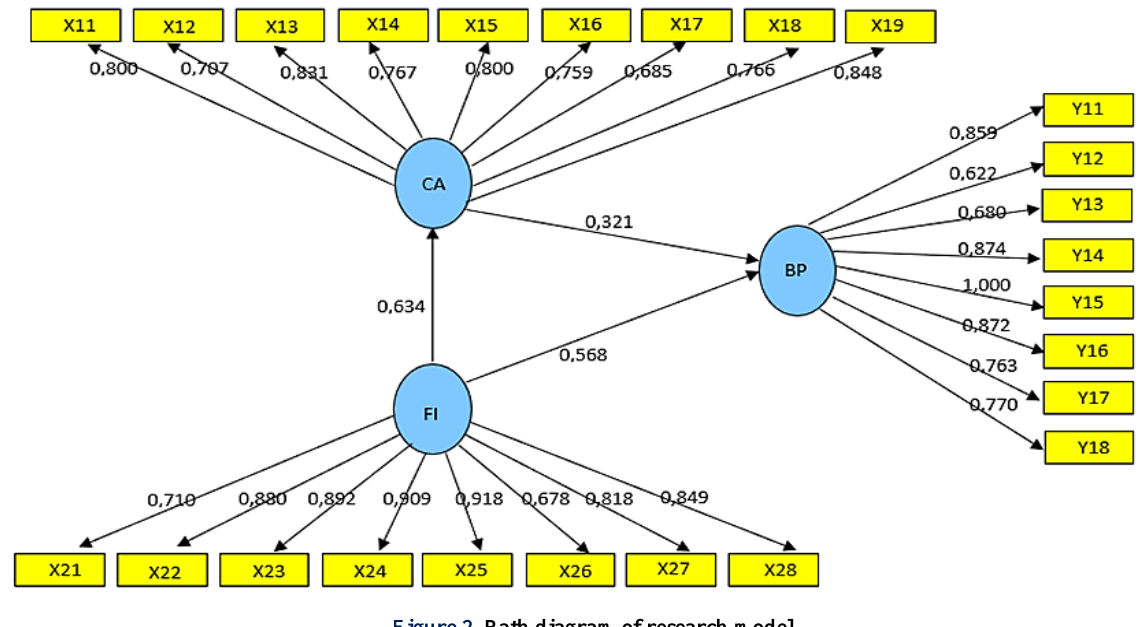
Figure 2. Path diagram of research model